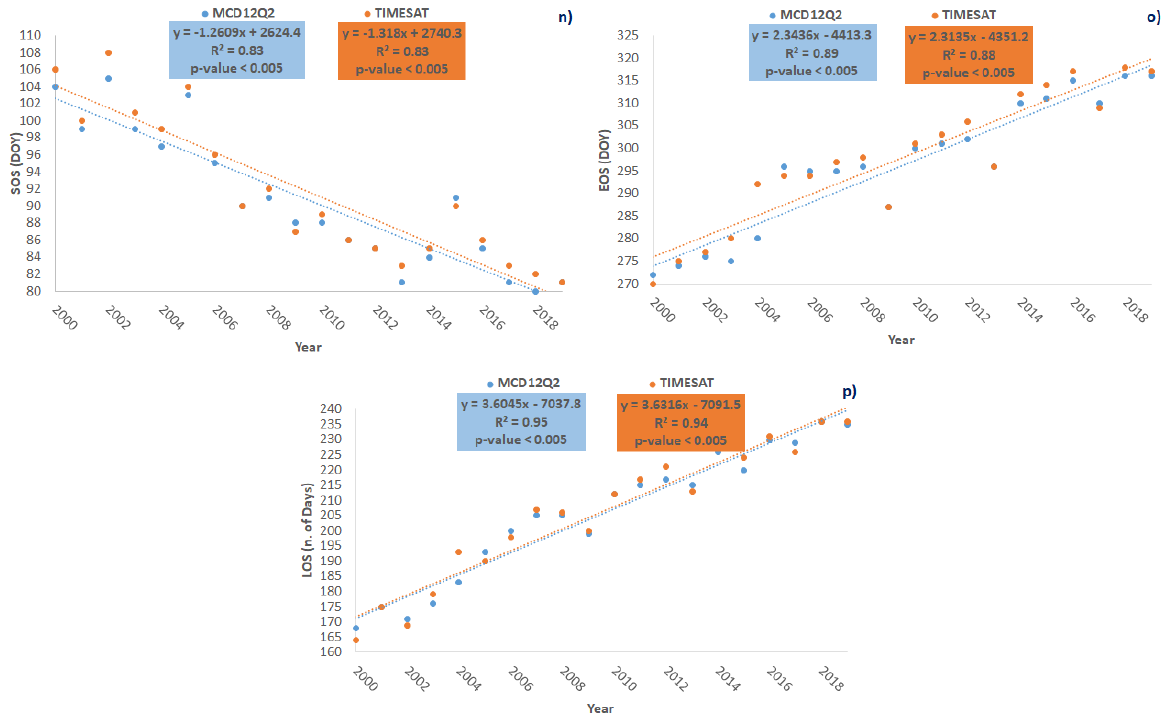
Figure 7. Yearly trends, respectively, of the SOS ( n ), EOS ( o ), and LOS ( p ) in Aosta Valley retrieved from TIMESAT starting from the collection MOD13Q1 v.6 (the ones that have to be validated) and the Phenological MODIS product MCD12Q2 (validated product used to test those obtained in TIMESAT).